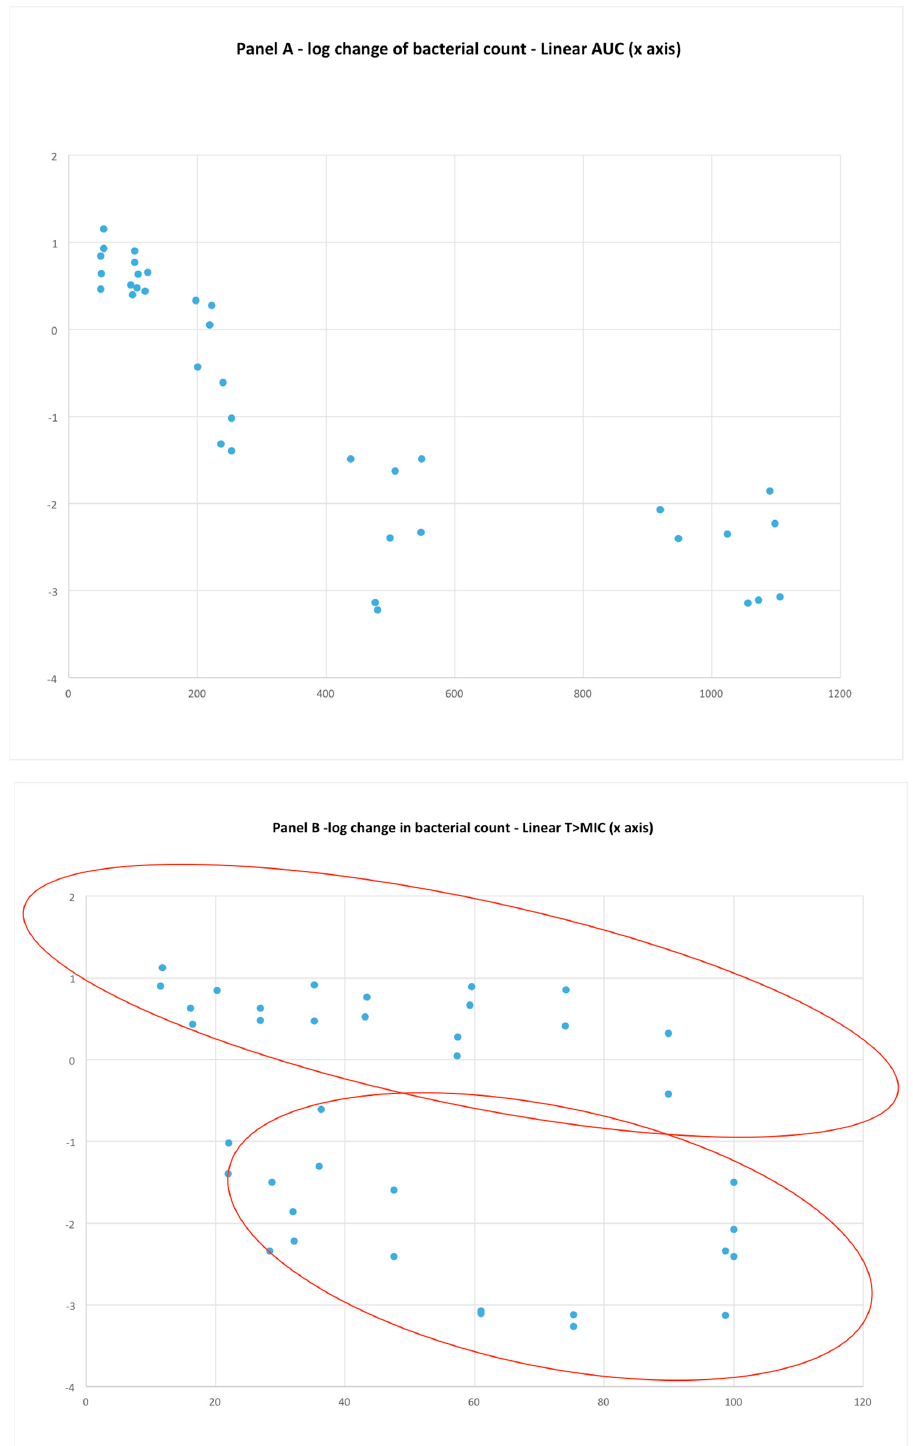
Figure 1. Depiction of the results of the methicillin sensitive Staphylococcus aureus (1 strain, MIC =1 mg/L) experiment by Ebert et al 1987 [29] from the review article by Rybak MJ, 2006 ([23], repro- duced with permission). Three pharmacokinetic/pharmacodynamics indices are plotted against 24 h change in bacterial count in thighs of mice. Note the methicillin-resistant strain results were not presented nor discussed in the text of the review.